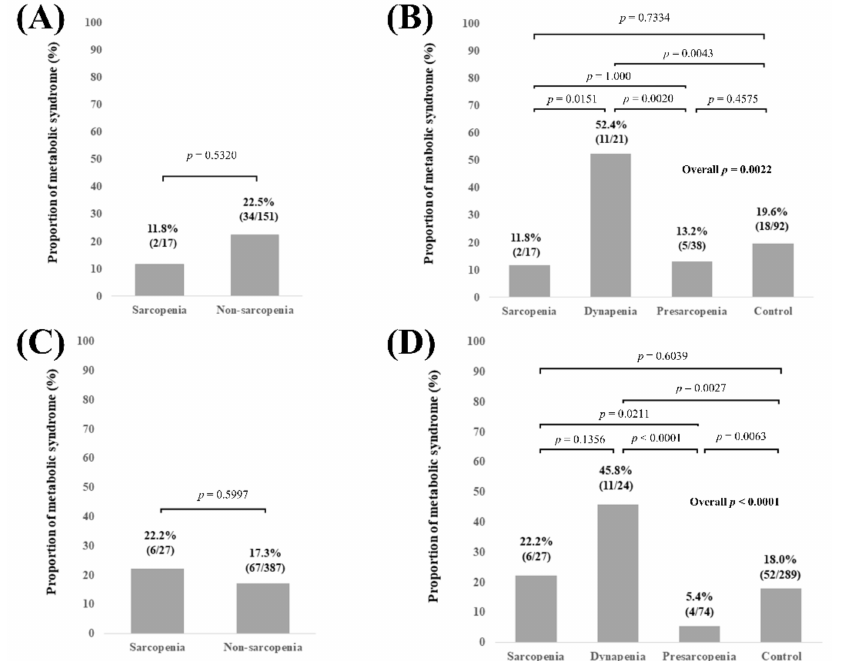
Figure 3. ( A ) Proportion of Met-S in patients with sarcopenia and non-sarcopenia in LC patients (n = 168). ( B ) Proportion of Met-S in patients with sarcopenia, dynapenia, presarcopenia, and control in LC patients. ( C ) Proportion of Met-S in patients with sarcopenia and non-sarcopenia in non-LC patients (n = 414). ( D ) Proportion of Met-S in patients with sarcopenia, dynapenia, presarcopenia, and control in non-LC patients.